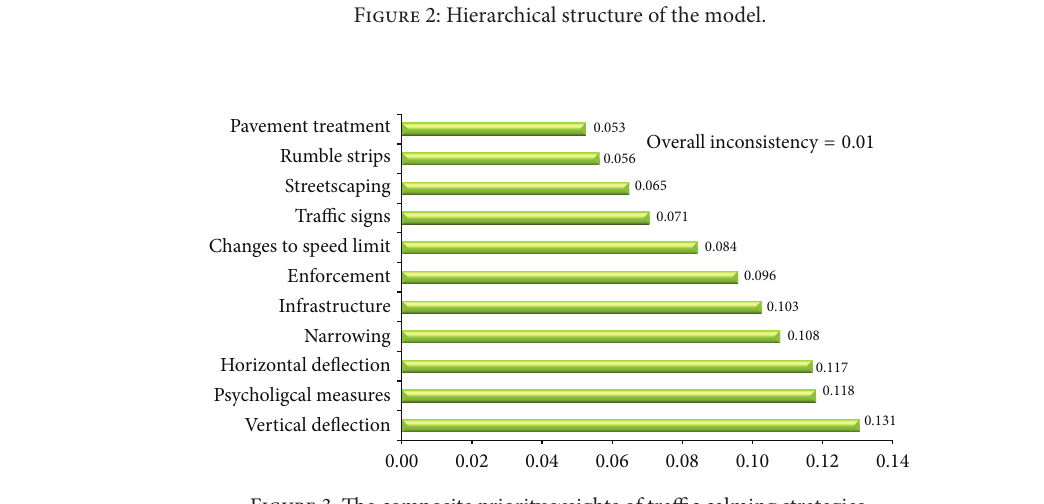
Figure 3: The composite priority weights of traffic calming strategies.